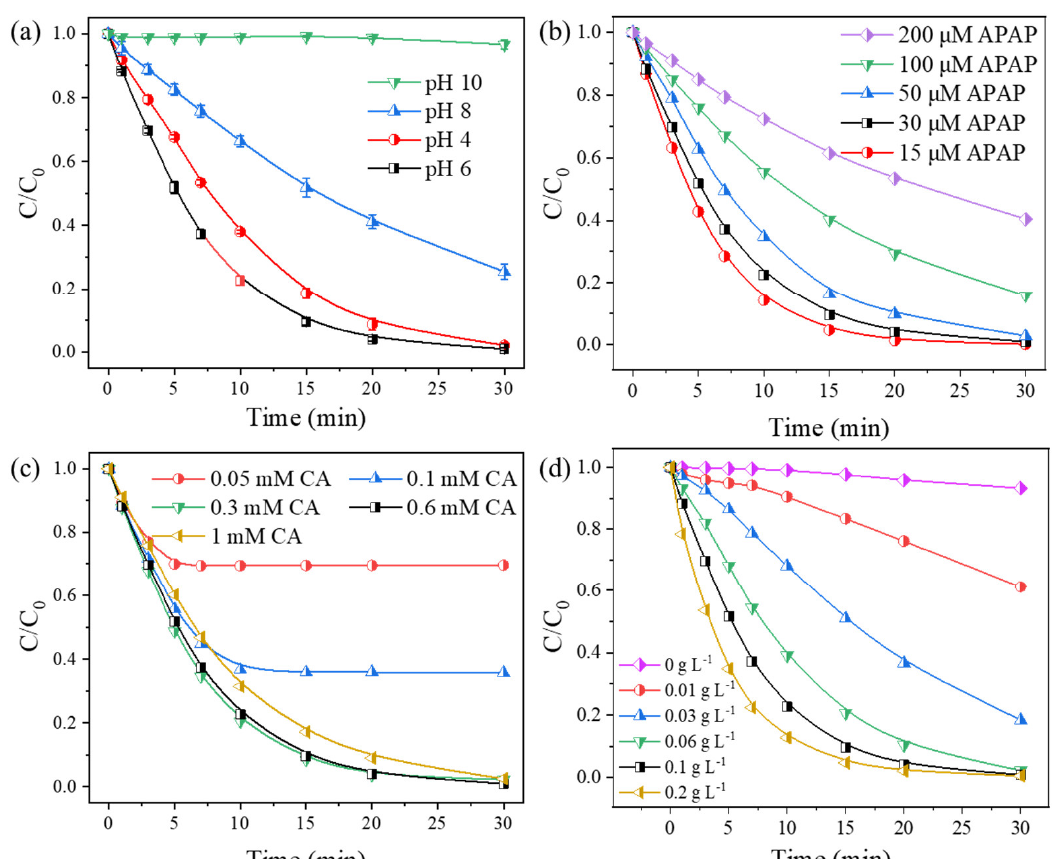
Figure 2. Effect of ( a ) initial pH, ( b ) initial APAP concentration, ( c ) initial CA concentration and ( d ) pyrite dosage on APAP degradation in the pyrite–CA–light system. Initial conditions: [pyrite] = 0.1 g L −1 , [APAP] = 30 μM, [CA] = 0.6 mM, pH ini = 6.